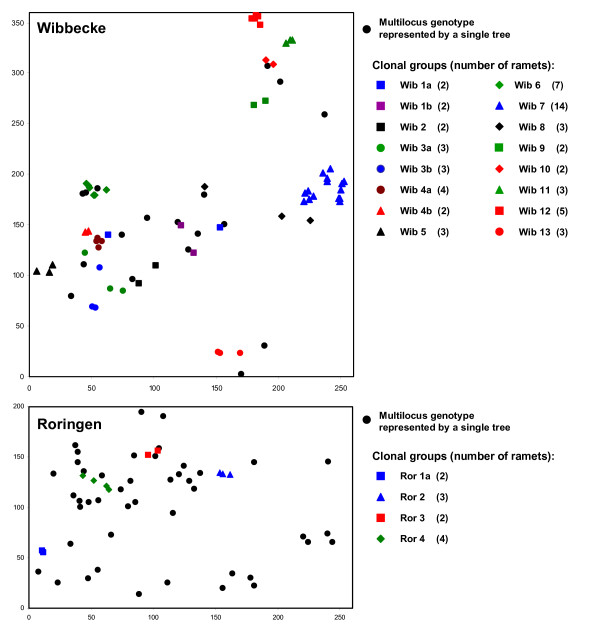
Map of the studied P. avium (wild cherry) stands. Location of adult P. avium (wild cherry) genotypes represented by a single tree and by groups of trees (clonal groups)